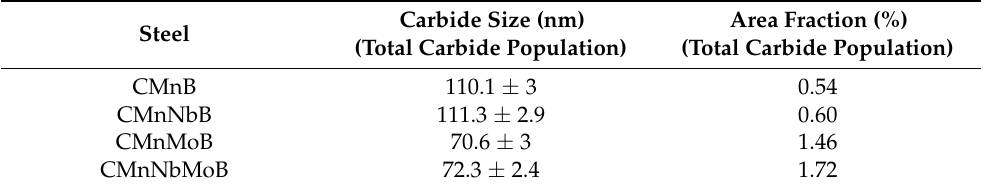
Table 4. Measured mean carbide sizes and carbide densities considering total carbide population (sum of high-angle and low-angle boundaries).